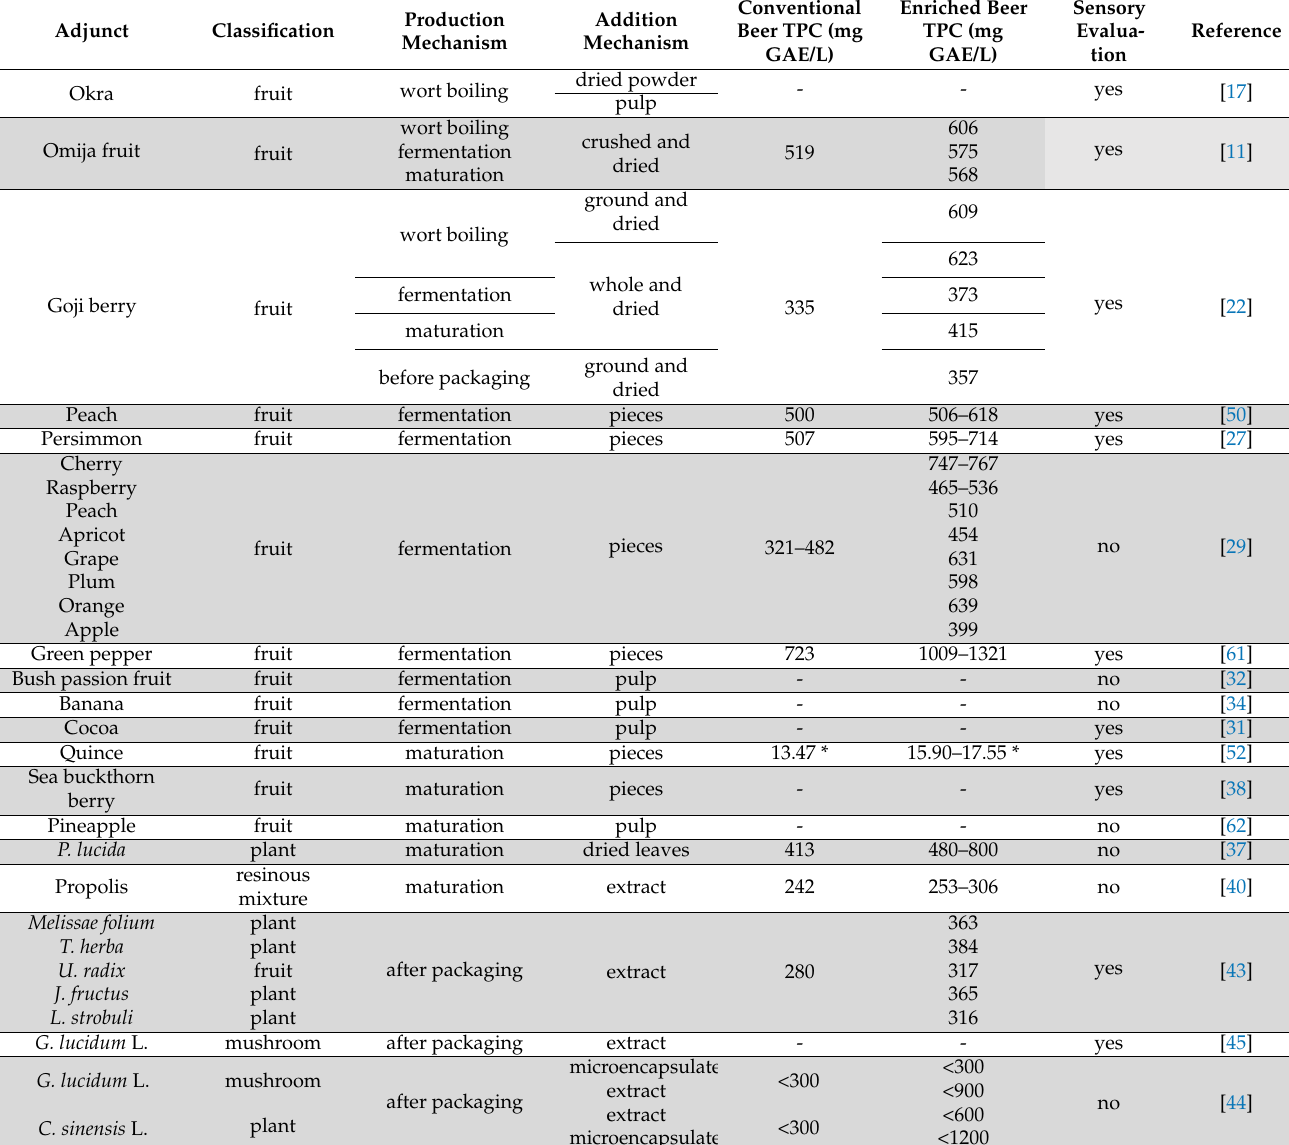
Table 1. Detailed compilation of studies regarding the production of functional beers and their total phenolic content.